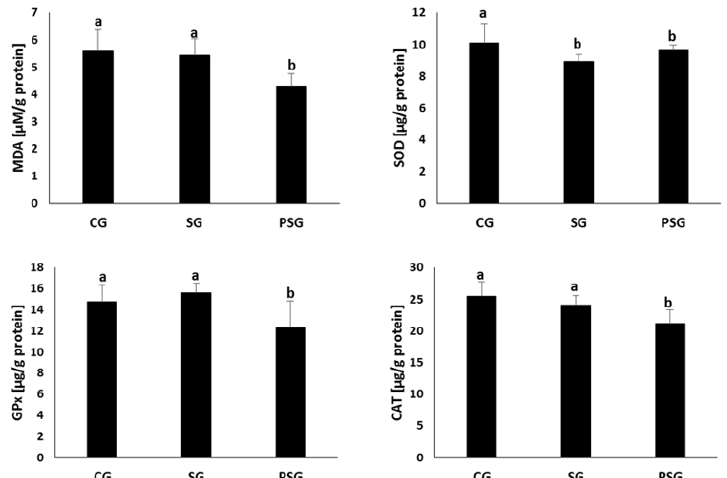
Figure 3. Effect of frequent changes in diet or periodic starvation on uterine malonyldialdehyde (MDA) concentrations and superoxide dismutase (SOD), glutathione peroxidase (GPx), catalase (CAT) activities. CG — Control group, SG — Sugar group, PSG — Periodically starved group, a, b — Means marked with different letters in the same line are statistically different, p ≤ 0.05.